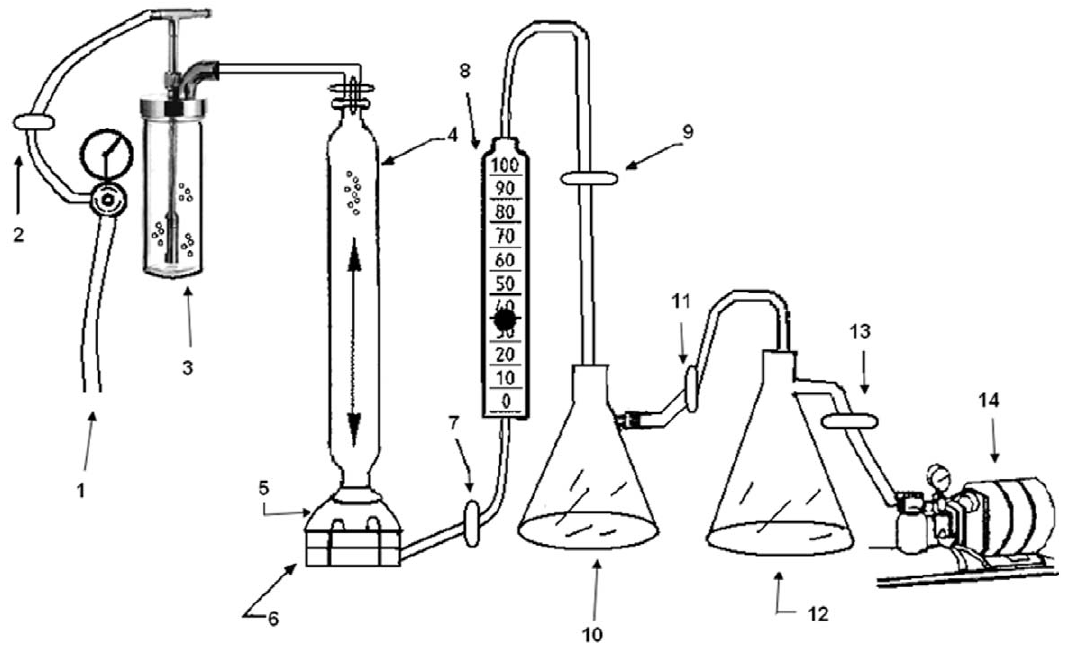
Figure 2. Viral aerosol challenge test apparatus scheme. Key: 1. High pressure air source; 2. Filter; 3. Nebulizer; 4. Aerosol chamber; 5. Test material chamber; 6. Anderson impactor; 7. Filter; 8. Calibrated flow meter; 9. Filter; 10. 4L vacuum flask; 11. Filter; 12. 4L vacuum flask; 13. Filter; 14. Vacuum pump.